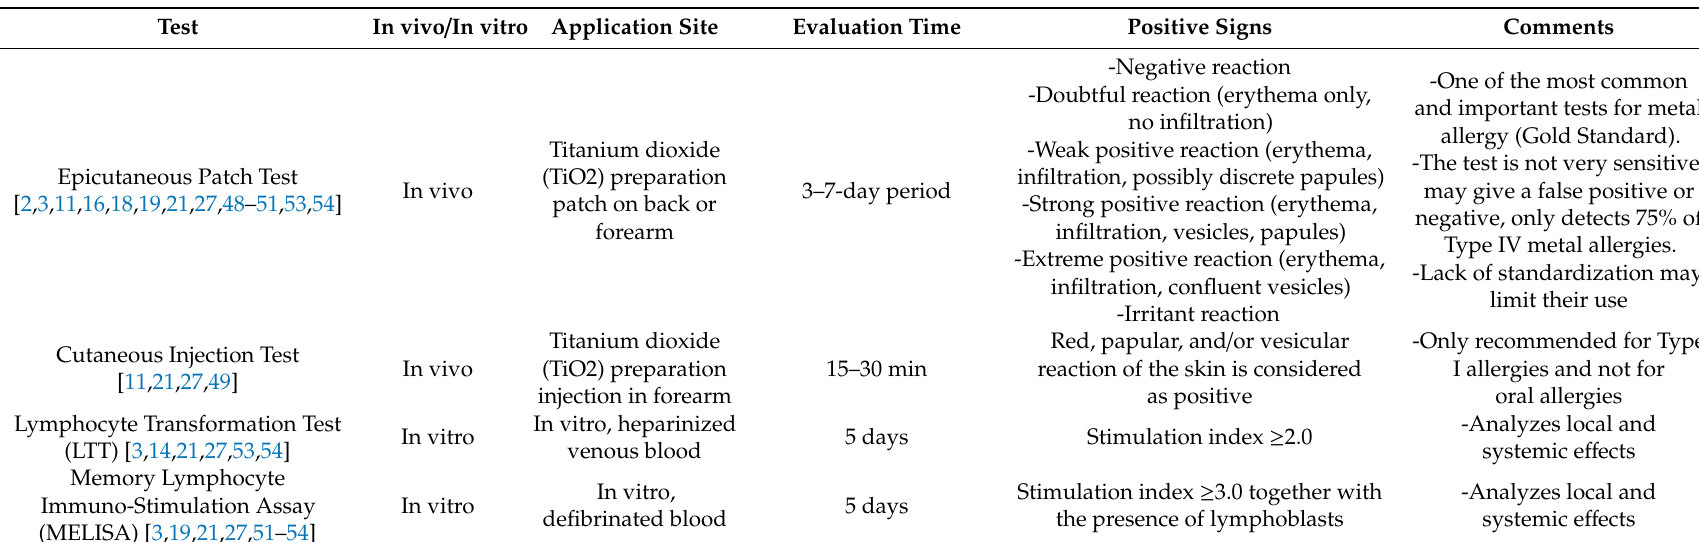
Table 4. Tests for metal